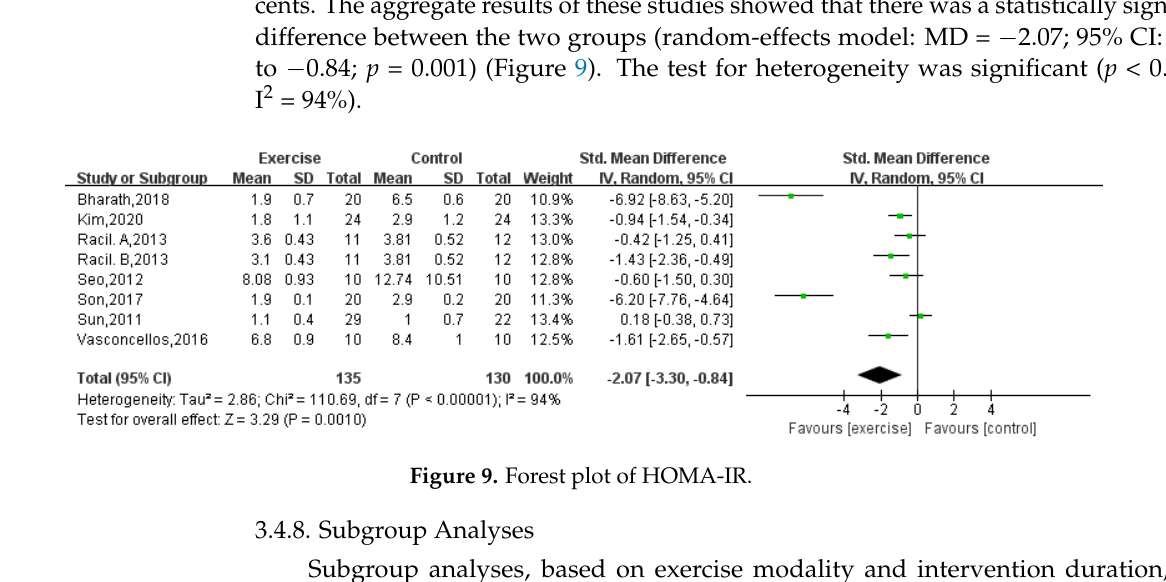
Figure 8. Forest plot of VO 2 peak.